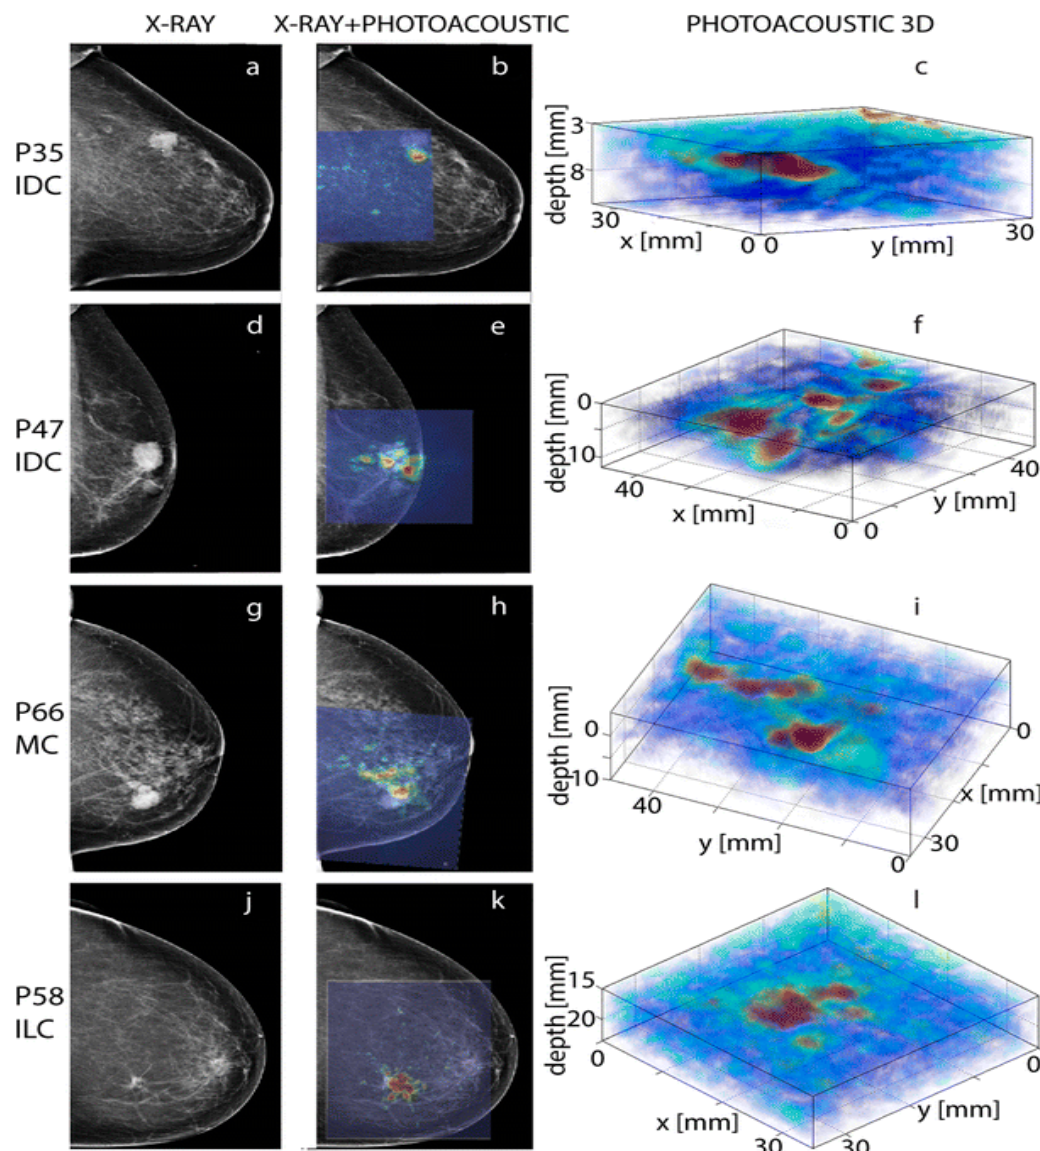
Figure 2. Comparison of PA imaging with X-ray mammograms. ( Left ): cranio-caudal (CC) X-ray mammogram; middle: PA images were overlaid on CC X-ray mammograms to show lesions in both modalities; ( Right ): detailed 3D representation of the lesion of interest. ( a – c ): Case 1, a 79-year-old patient with IDC, ( d – f ): Case 2, a 79-year-old patient with IDC, ( g – i ): Case 3, an 83-year-old patent with MC, and ( j – l ): Case 4, a 65-year-old patient with ILC. PXX indicates patient identifier used in this study. Reproduced from Heijblom et al. [35], which is distributed under the terms of the Creative